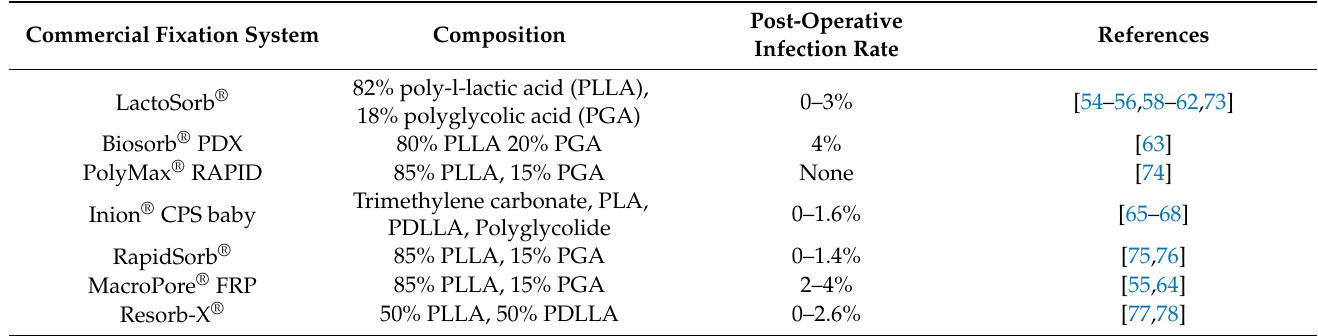
Table 3. Commercial rigid fixation systems based on biodegradable